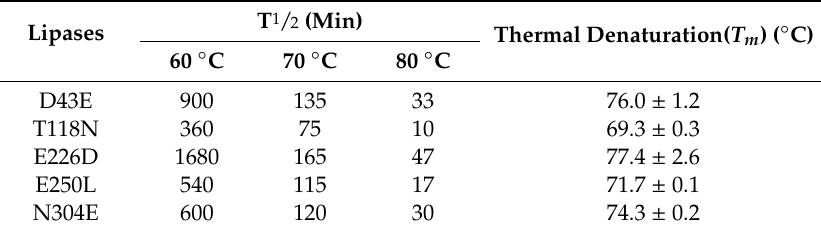
Figure 2. Effects of temperatures on activity of mutated HT1 lipase. The activity was determine using colorimetric assay and the optimum activity of each enzyme was recorded as 100%. The protein concentrations were standardized to 50 µg for each sample. The assays were conducted in triplicate. Table 1. Thermostability study of mutants HT1 lipase.